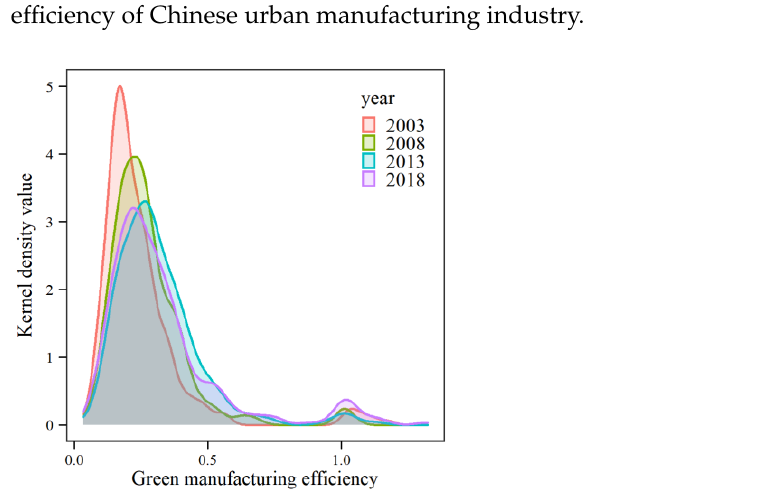
Figure 2. Kernel density of green manufacturing efficiency in China, 2003 to 2018. Furthermore, to reflect regional differences, the cities in the study sample were divided into four regions belonging to the east, west, central, and northeast [49]. In four research years (Figure 3), the inflection points of the regional nuclear density peak was lower than 0.5, which was in alignment with the trend toward green manufacturing efficiency in China. By region, green manufacturing efficiency had a trend of equalization, with the eastern region ranking first, followed by the central, northeastern and western regions, in that order. The green manufacturing efficiency of the eastern cities showed an explosive development stage of efficient cities, and the gap between the number of green manufacturing efficiency cities and other regions widened. The green manufacturing efficiency peak inflection point in central cities kept the trend of a rising peak. The Northeast gradually overtook the central region from the low green manufacturing efficiency cluster. In 2013, the nuclear density curves of the two remained basically the same, and there was a great tendency to catch up. However, the peak of the kernel density curve in Northeast China in 2018 was significantly lower than that in Central China, indicating that the efficiency of green manufacturing in the old industrial base in Northeast China, where heavy industry is the main production industry, was more affected by environmental regulations. Regarding the green manufacturing efficiency of western cities, although it was the region with the lowest peak value of nuclear density, it was the region with the greatest development potential. Compared with the nuclear density curves in central and northeast China in 2003, the difference of nuclear density curves in western China in 2018 was significantly reduced, indicating that the difference in green manufacturing efficiency among regions was shifting to balanced